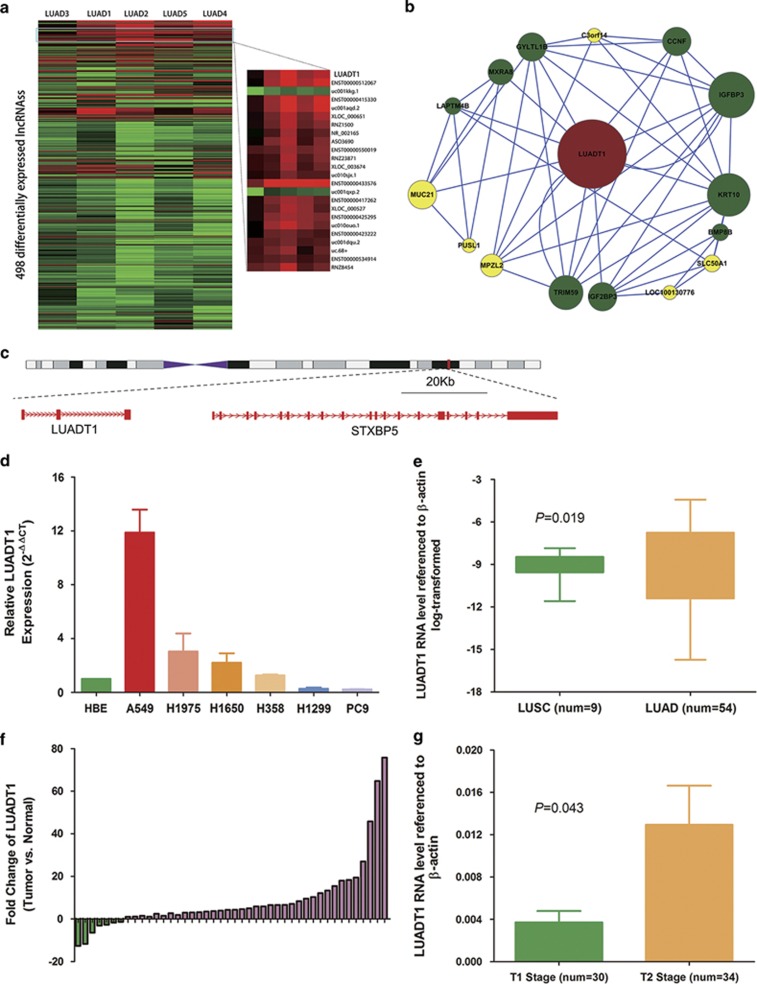
LUADT1 is upregulated in LUAD. (a) Hierarchical clustering showed that LUADT1 is significantly highly expressed; green: downregulated lncRNAs; red: upregulated lncRNAs. (b) Co-expression sub-network of LUADT1; green: genes associated with cell proliferation, drug resistance, tumor growth, invasion or prognosis; yellow: genes with unknown function. (c) Chromosomal location of LUADT1. (d) Expression of LUADT1 in LUAD cell lines. (e) LUADT1 is upregulated in NSCLC tissues compared with non-tumor tissues (8.34-fold, P<0.05). The LUADT1 expression level is higher in LUAD tissues than in LSCC tissues (f) and is higher in T2 stage tumors than in T1 stage tumors (g). Error bars indicate means±S.E.M.